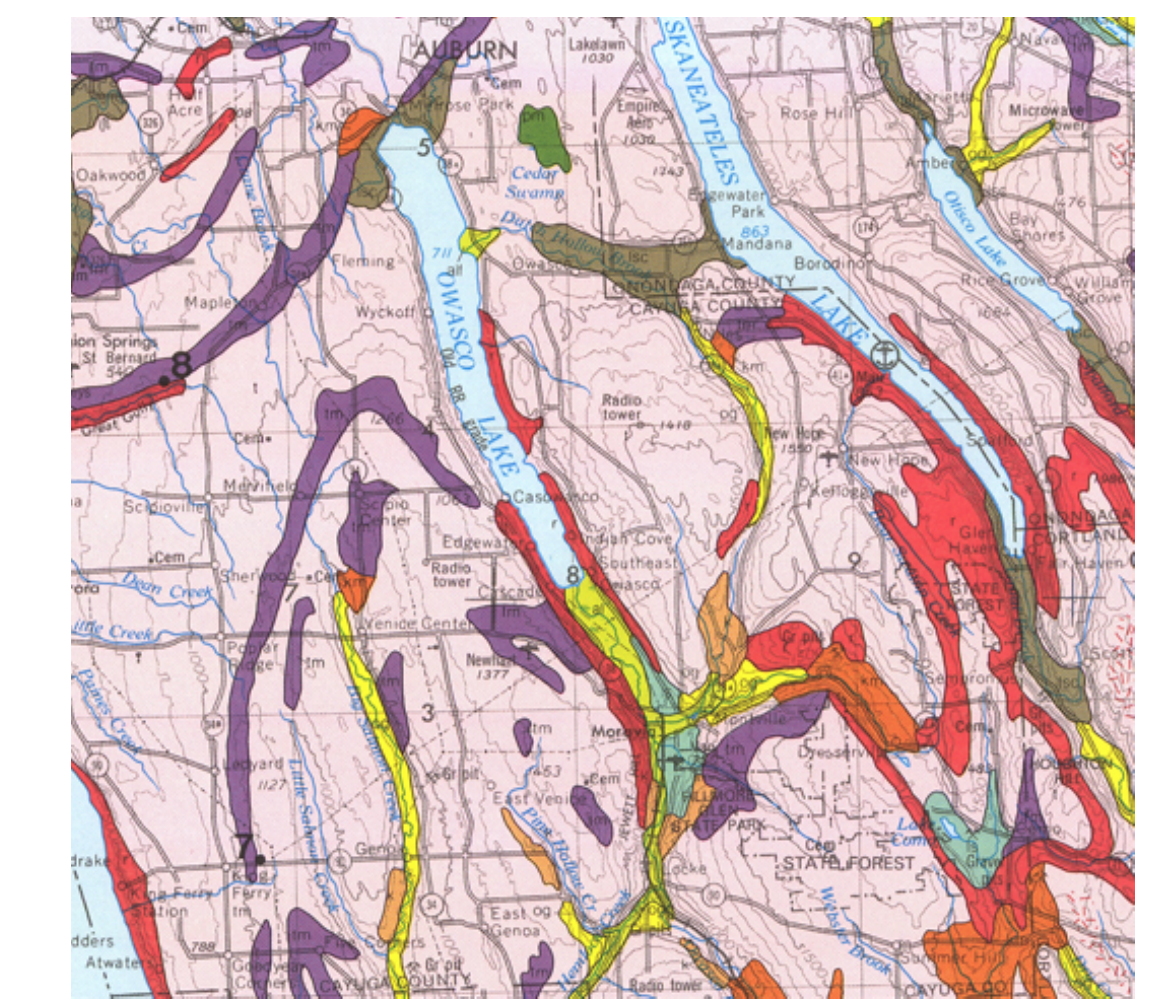
Figure 2. Surficial geology of central New York state near Moravia, NY. The ground moraine (pink; if stippled shallow over bedrock), proglacial lakes (brown), organic swamps (dark green), bedrock or very thin soil cover (red), till moraine (purple), kame moraines (orange), lacustrine sand (light green), and outwash sand and gravel (yellow) are shown (Source: New York State Geological Survey, 1986).